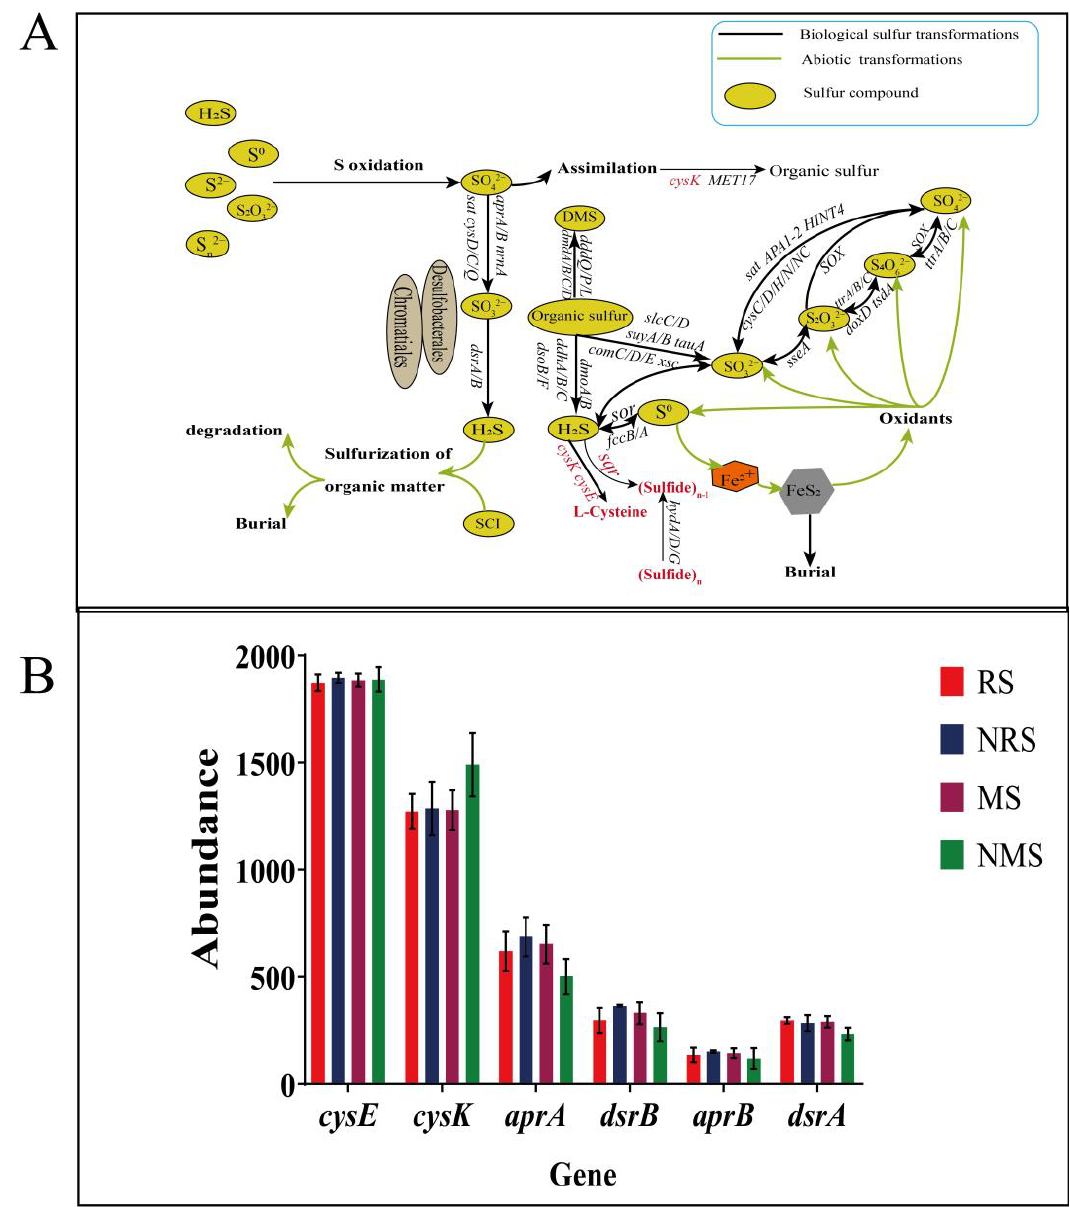
Figure 7. ( A ) Conceptual depiction of sulfide conversion in the mangrove ecosystem, including biological and abiotic processes. Biological processes include oxidation and reduction of sulfur compounds. Black lines depict biological sulfur transformations by microorganisms. Green lines depict abiotic-reaction-mediated sulfur transformations to pyrite (FeS 2 ). Sulfur compounds are depicted within yellow eclipses. ( B ) Abundance values of cysK, cysE, dsrA, dsrB, aprA , and aprB in samples.